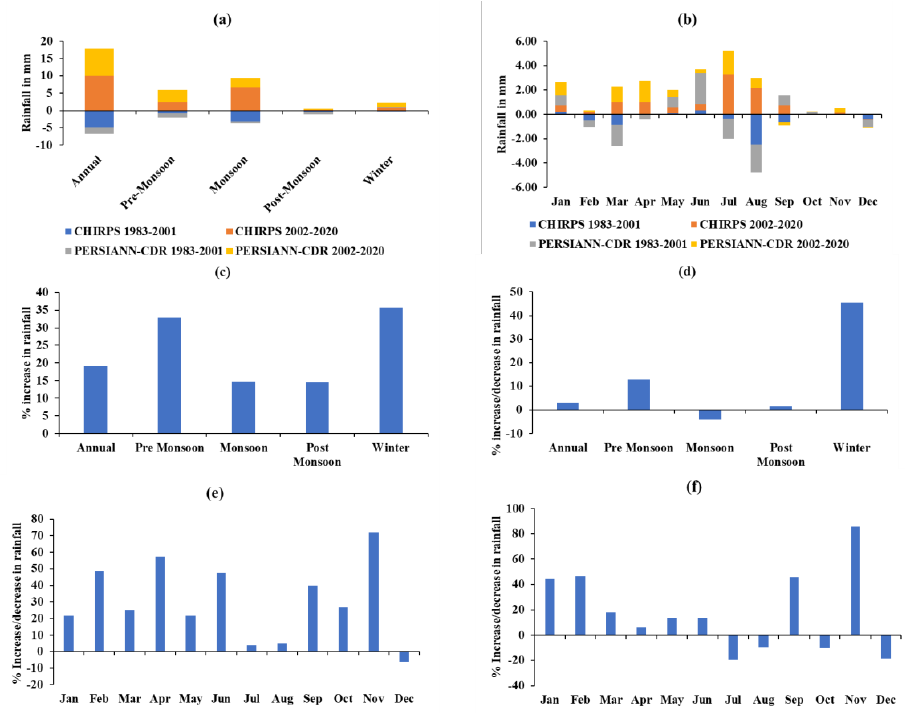
Figure 5. Phase-wise trends and mean percentage change in rainfall in central Punjab through CHIRPS and PERSIANN-CDR (1983 – 2001 and 2002 – 2020). ( a ) Trends on annual and seasonal scales; ( b ) trends on a monthly scale; ( c ) percentage mean annual and seasonal change in CHIRPS from Phase-1 to Phase-2; ( d ) percentage mean annual and seasonal change in PERSIAN-CDR from Phase-1 to Phase-2; ( e ) percentage mean monthly change in CHIRPS from Phase-1 to Phase-2; ( f ) percentage mean monthly change in PERSIANN-CDR from Phase-1 to Phase-2.